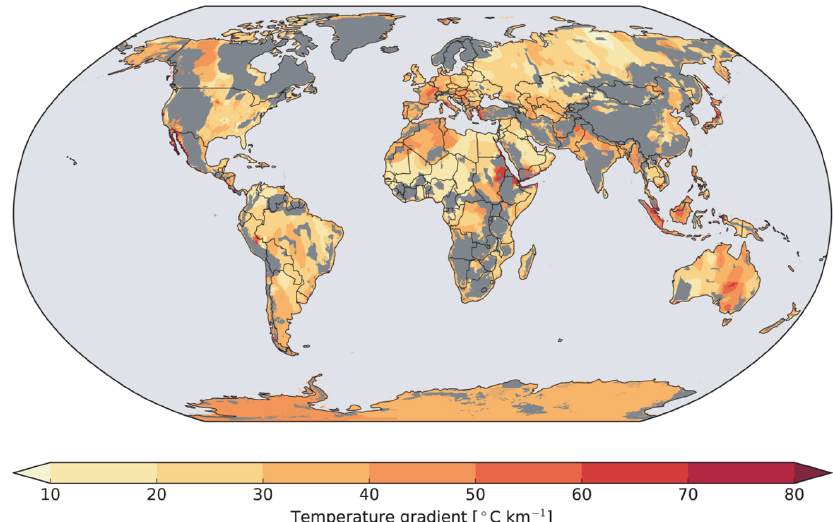
Figure 9. Computed geothermal gradients in aquifers [25] .